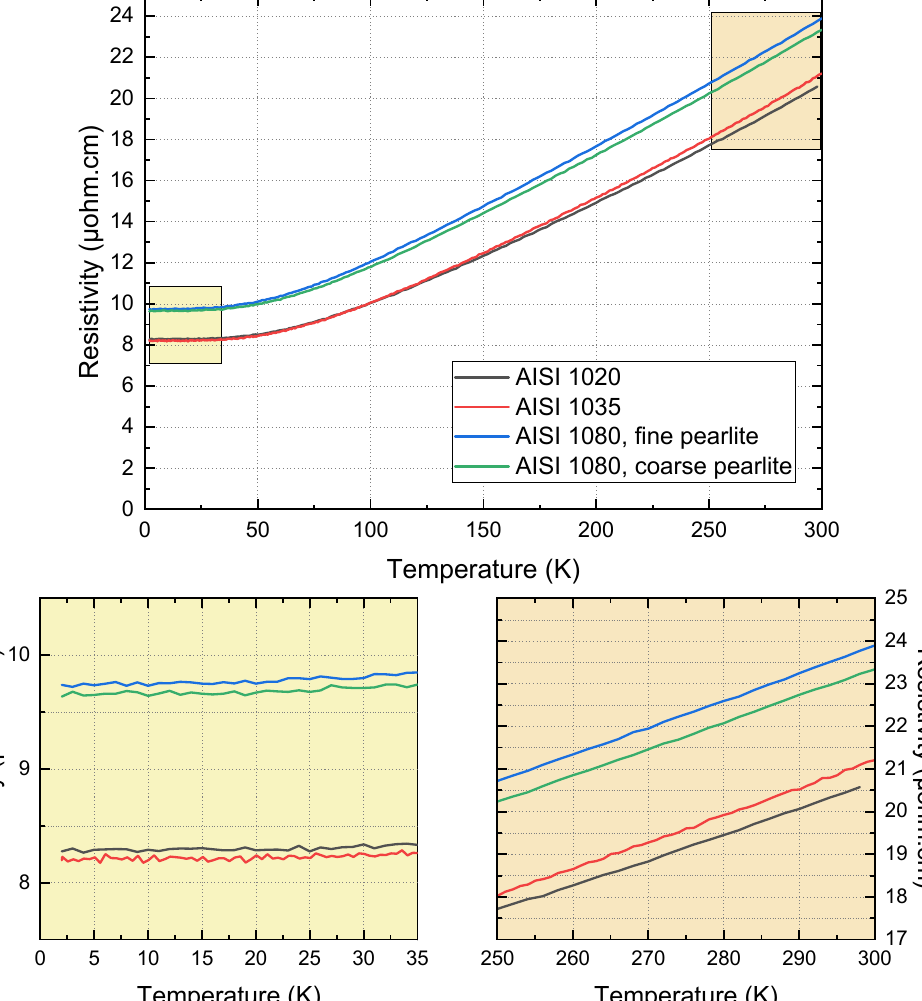
Figure 4. Temperature dependence of electrical resistivity of ferrite-pearlite samples ( top ); in detail, the temperature regions from 2 to 35 K ( bottom left ) and from 250 to 300 K ( bottom right ).